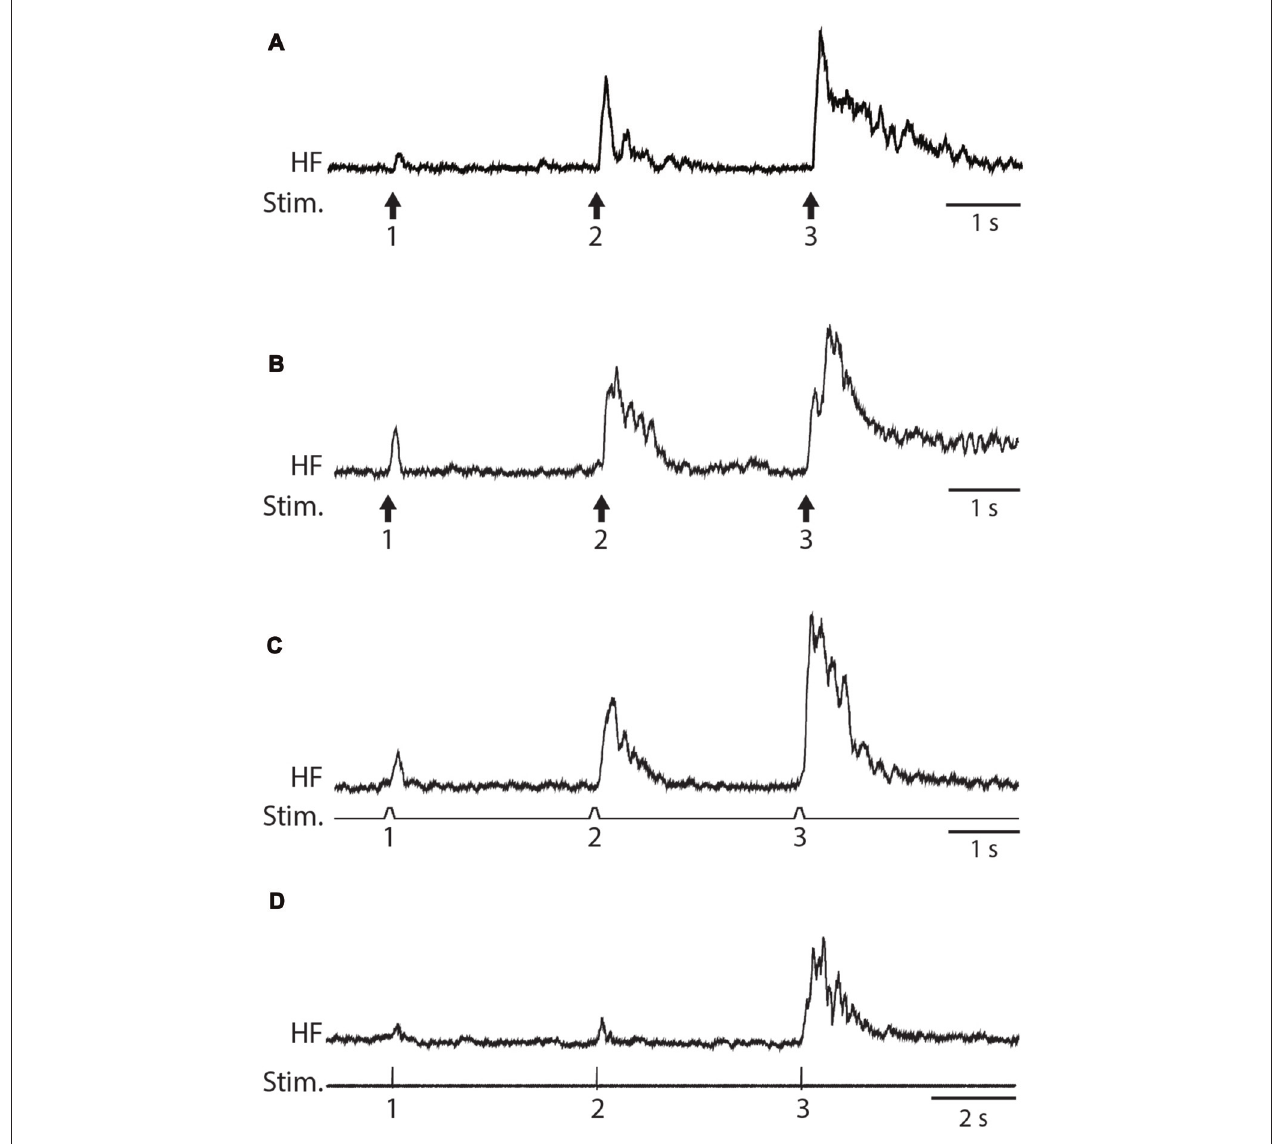
FIGURE 2 | Examples of flexion reflex windup. (A) 2-g (20-mN) von Frey filament taps to the dorsal hindlimb foot skin, with 3-s interstimulus intervals. (B) 4-g (39-mN) von Frey filament taps to the dorsal hindlimb foot skin, with 3-s interstimulus intervals. (C) Electrical pulses to the dorsal hindlimb foot skin, with 3-s interstimulus intervals. (D) Electrical pulses to the dorsal hindlimb foot skin, with 5-s interstimulus intervals. HF, hip flexor nerve recording (rectified and smoothed); Stim.,